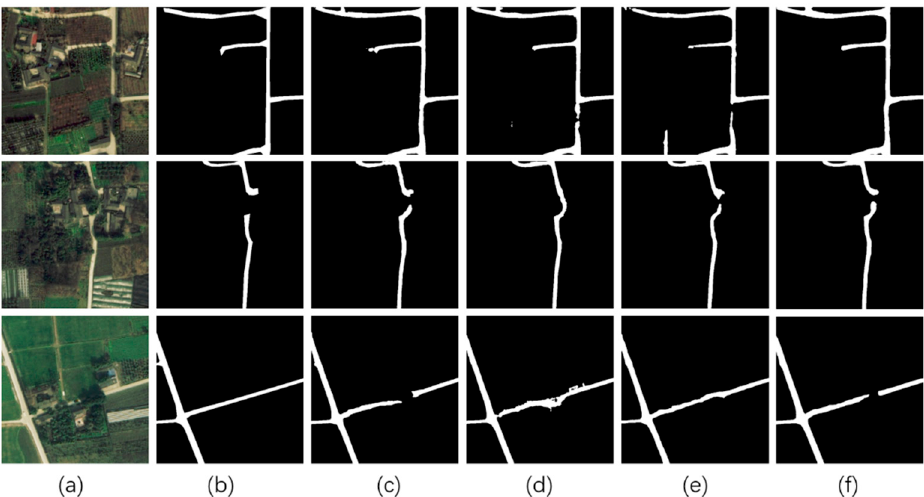
Figure 21. Low-grade road extraction in complicated scene images ( a ) input image; ( b ) label image; ( c ) D-linkNet; ( d ) S-DenseNet; ( e ) SD-DenseNet; ( f ) SDG-DenseNet. Table 5. Results of the Chongzhou–Wuzhen test set on different models. The bold font indicates the optimal value under the current evaluation metrics.